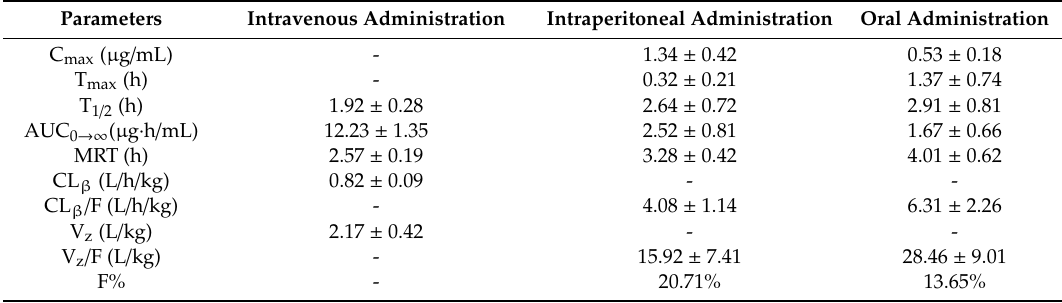
Figure 4. Mean plasma concentration–time curves of amphenmulin in mice after intravenous, intraperitoneal, and oral administration at a dose of 10 mg/kg. Table 3. Pharmacokinetics parameters of amphenmulin in mice after intravenous, intraperitoneal, and oral administration.